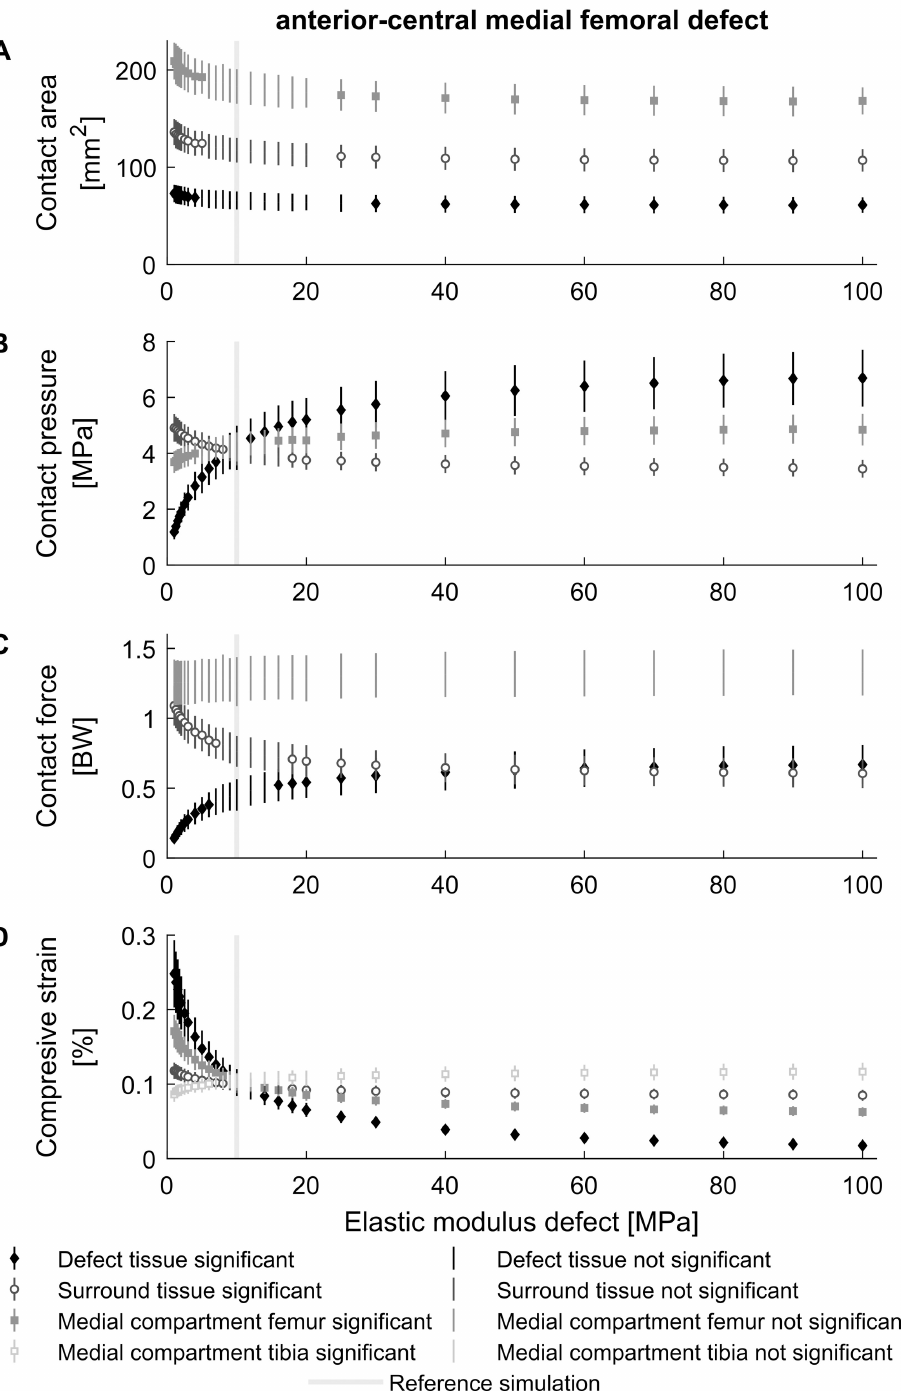
Fig 7. The influence of defect stiffness on local contact metrics. The effect of different elastic moduli on the average contact pressure (A), contact area (B), contact force (C) and average compresssive strain (D) inside and surrounding the defect and medial compartment of the anterior-central defect in the medial femur throughout the stance phase of gait (mean ± standard deviation). Significant differences compared to the reference simulation (gray line) at 5% significance level are indicated by dots on the error